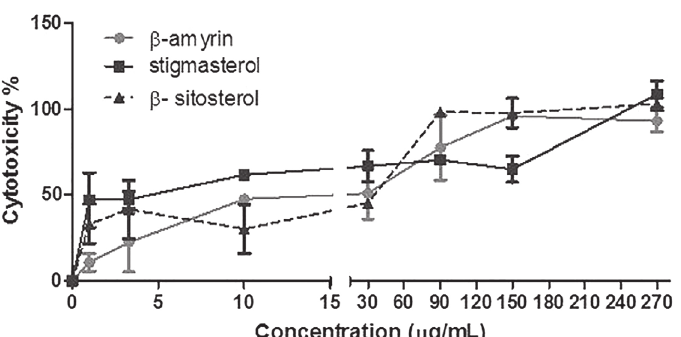
FIGURE 9 - Comparative cytotoxic activities in percentage values for the isolated compounds from the hexane partition (HP), as follows: β-amyrin, β-sitosterol and stigmasterol against K562 cell line, in different concentrations (270, 150, 90, 30, 10, 3 and 1 μg.mL -1 ). The results express the average of three independent experiments in triplicate. The cells (10 6 .mL -1 ) was incubated only with culture medium (control C), or, with different concentrations of the samples by 48 h, at 37ºC, in humid atmosphere, with CO (5%). Statistical was performed by one-way ANOVA followed by Tukey’s t-test (p < 0.05).